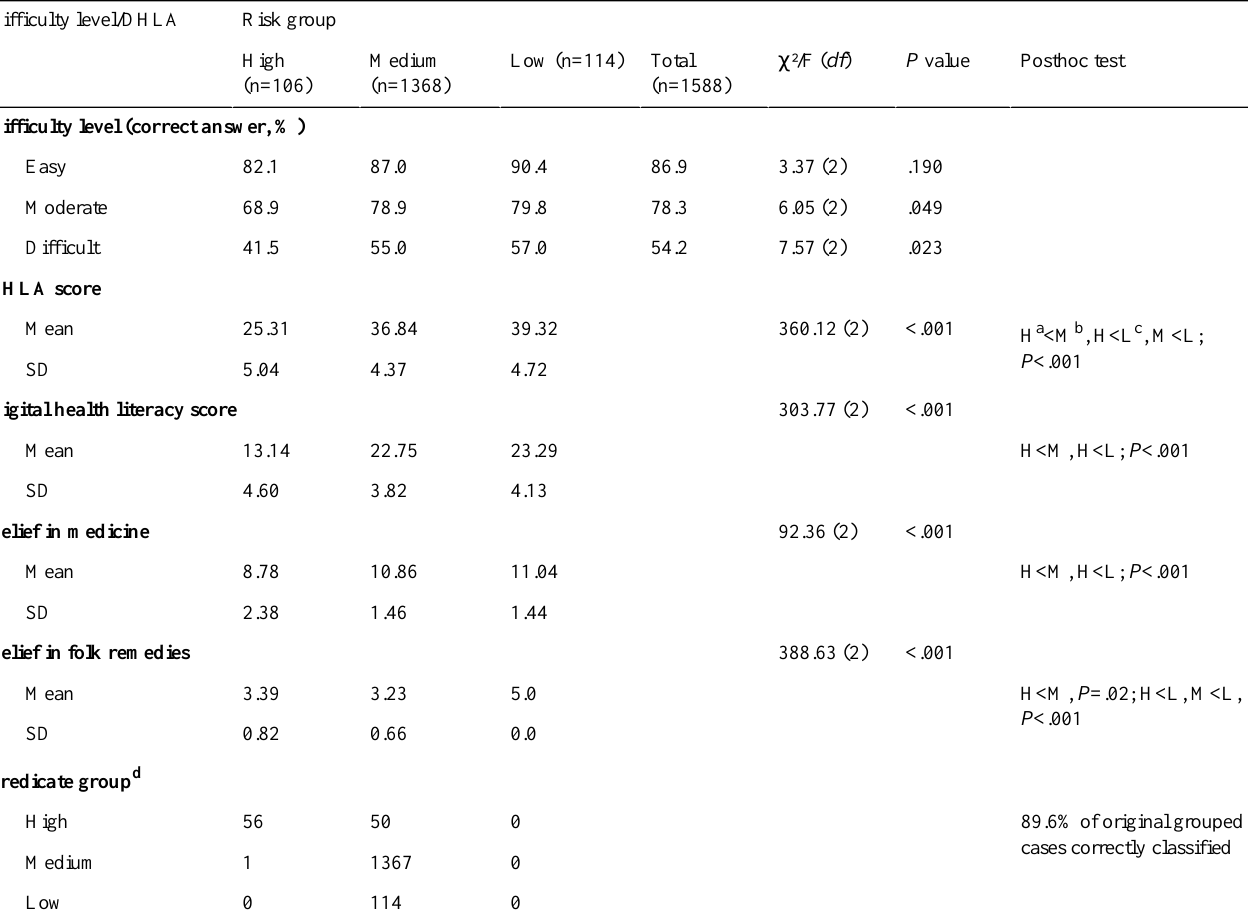
Table 4. Comparison of proportion of accurate judgments of online health information sources and digital health literacy assessment (DHLA) scores across different risk